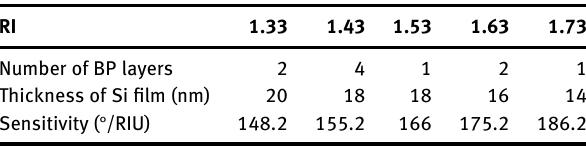
RI, refractive index; BP, black phosphorus; GWSPR, guided-wave surface plasmon